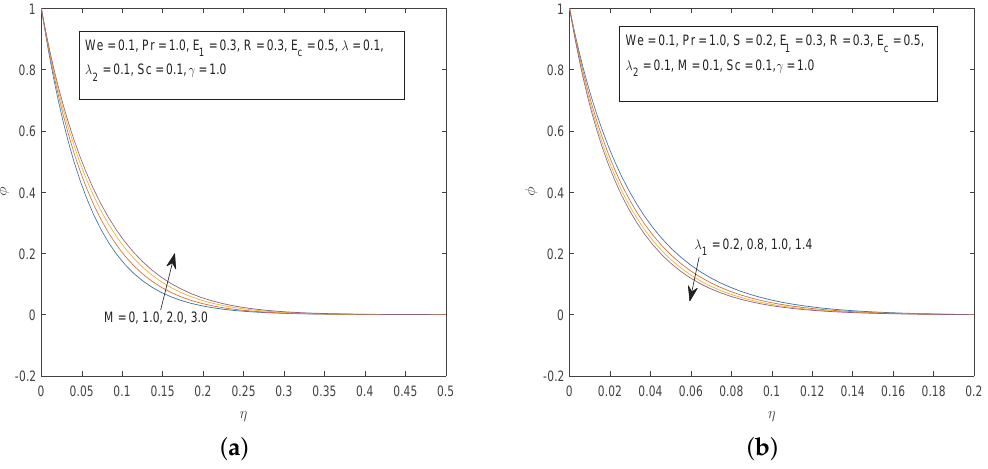
Figure 7. ( a ) Effects of M on φ and ( b ) Effects of λ 1 on φ .